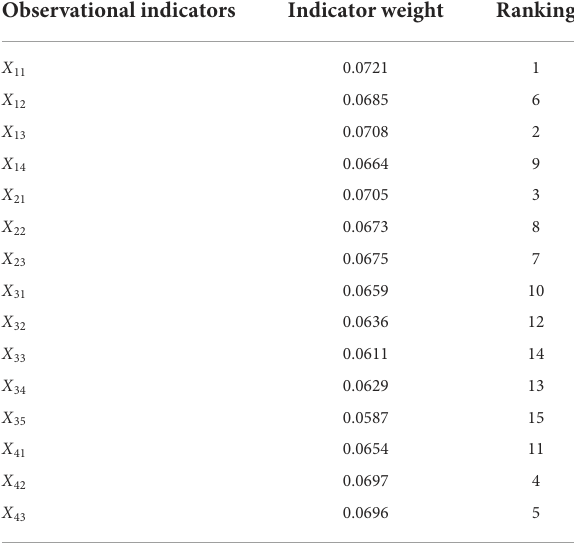
TABLE 7 Observation indicator weight and their